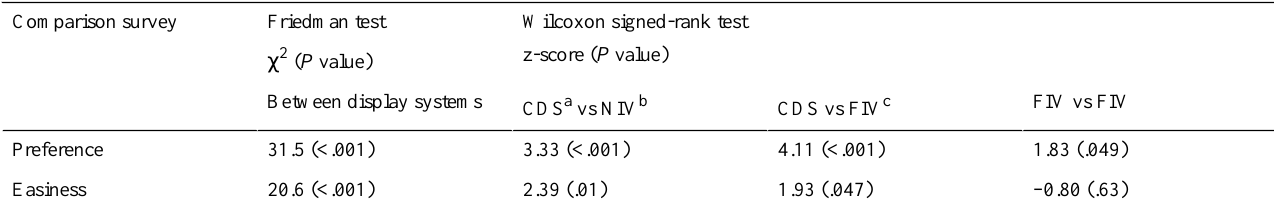
Table 7. Friedman test and Wilcoxon signed-rank test results on the comparison survey between the display systems.